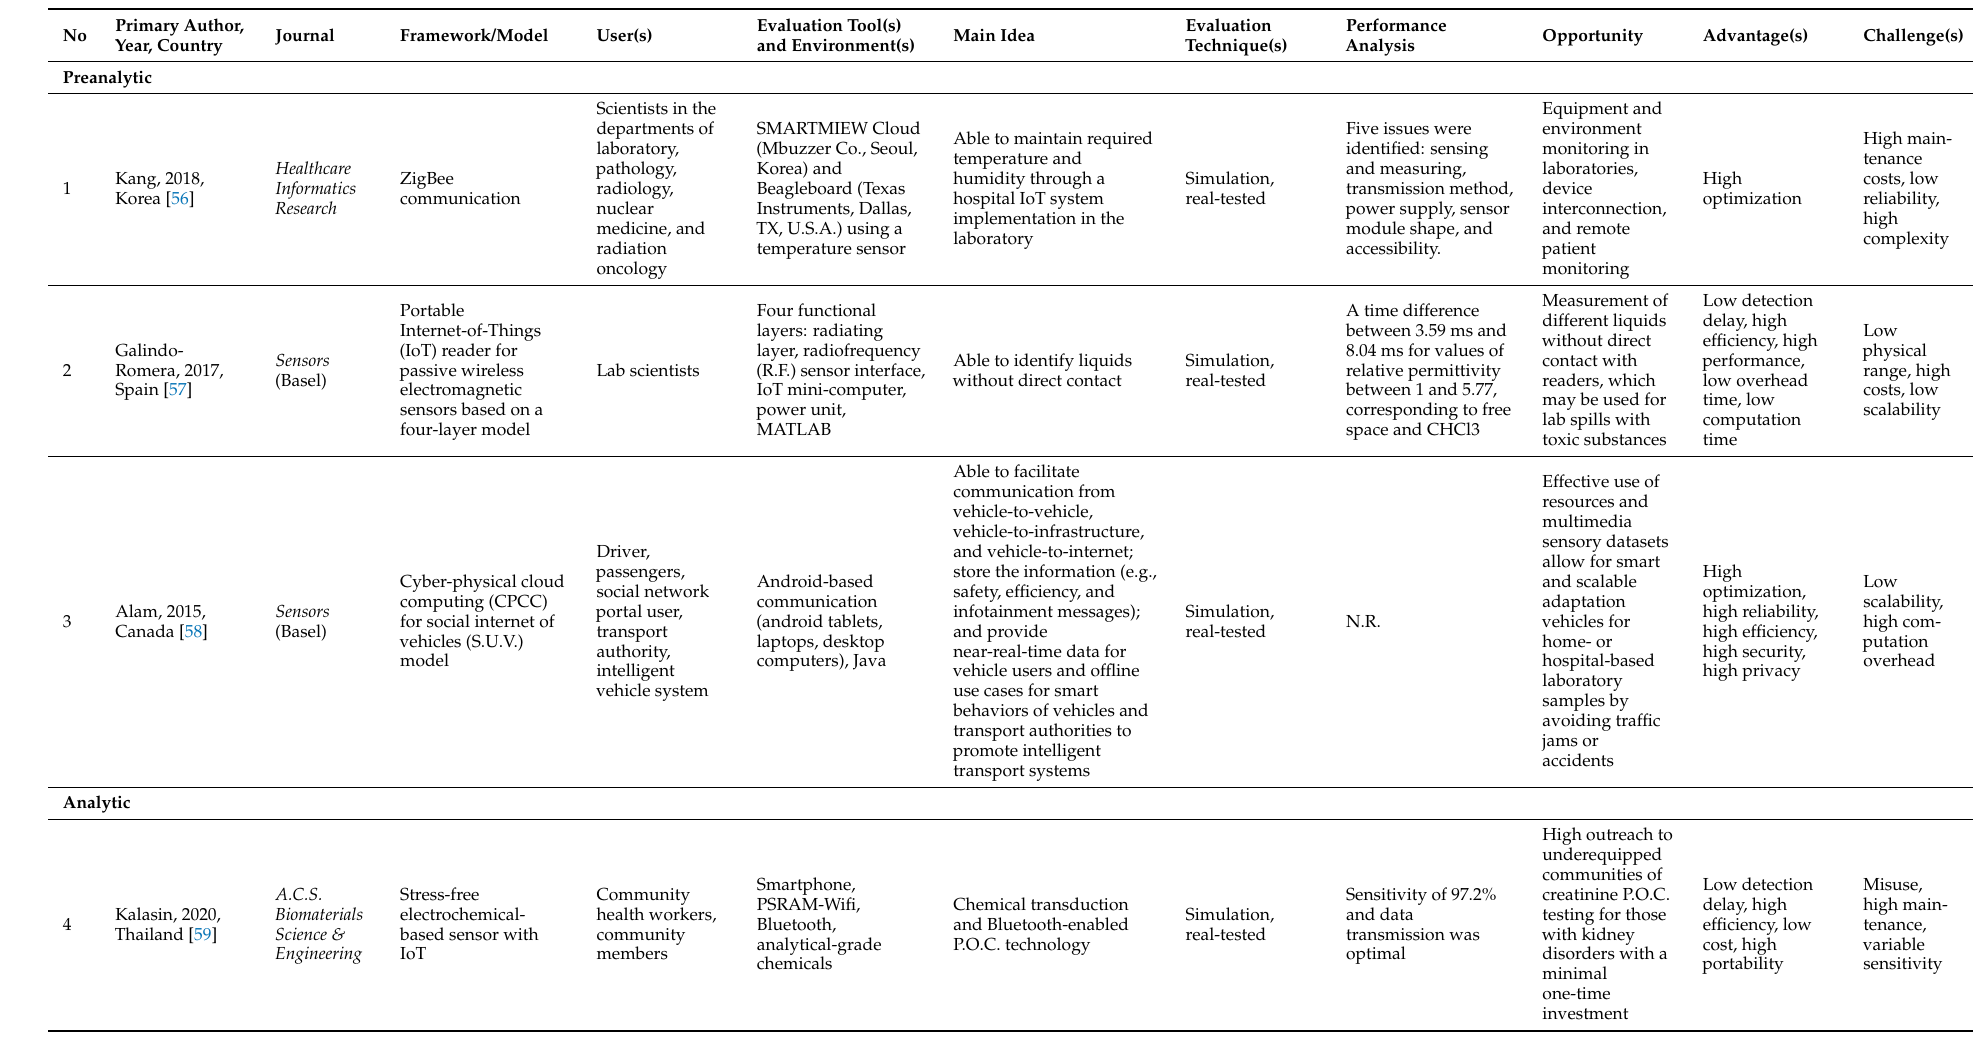
Table 3. Summary of the framework/model, users, tools and evaluation environment, main idea, evaluation techniques, performance analysis, and opportunity of the included